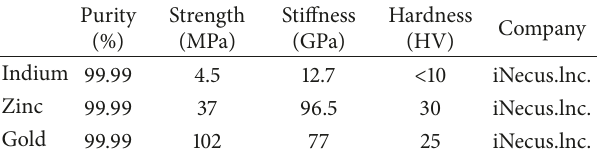
Table 2: Specifications of cured PDMS and coating